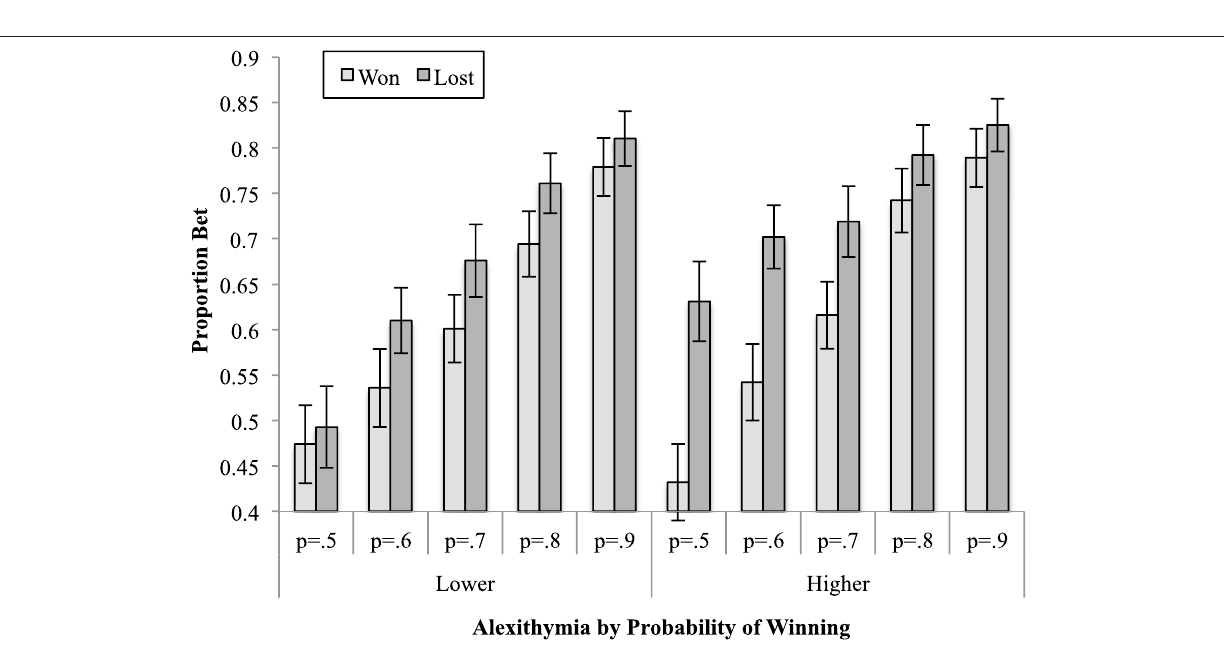
FIGURE 5 | The means (and standard errors) of the proportion bet for the outcome of the previous trial by the probability of winning on the current